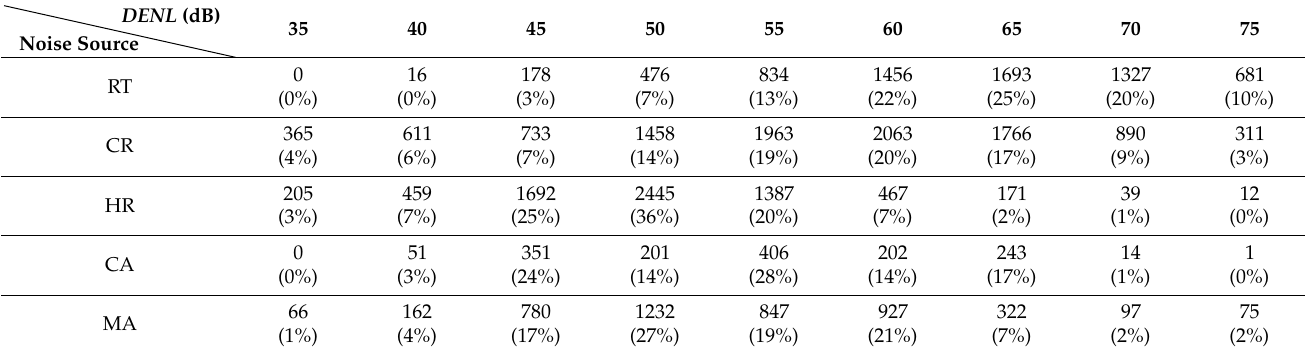
Table 4. Frequency distributions of noise exposure for each noise